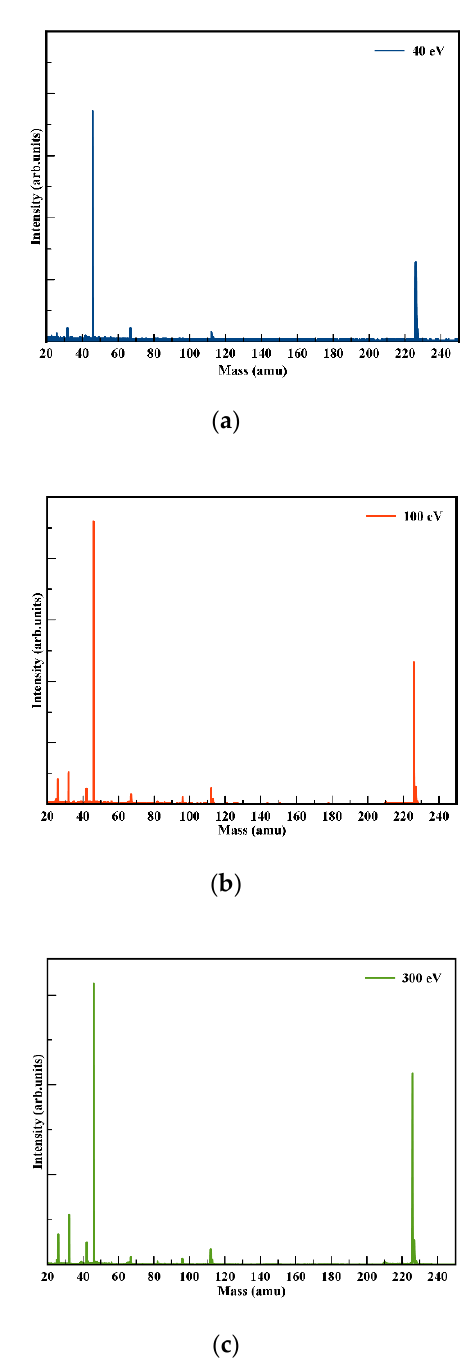
Figure 2. Time-of-flight negative ions mass spectra in neutral potassium collisions with neutral nimorazole at: ( a ) 40 eV lab frame (30.7 eV center-of-mass); ( b ) 100 eV lab frame (76.7 eV center-of- mass); ( c ) 300 eV lab frame (230.2 eV center-of-mass). See text for details and Table 1 for assignments.